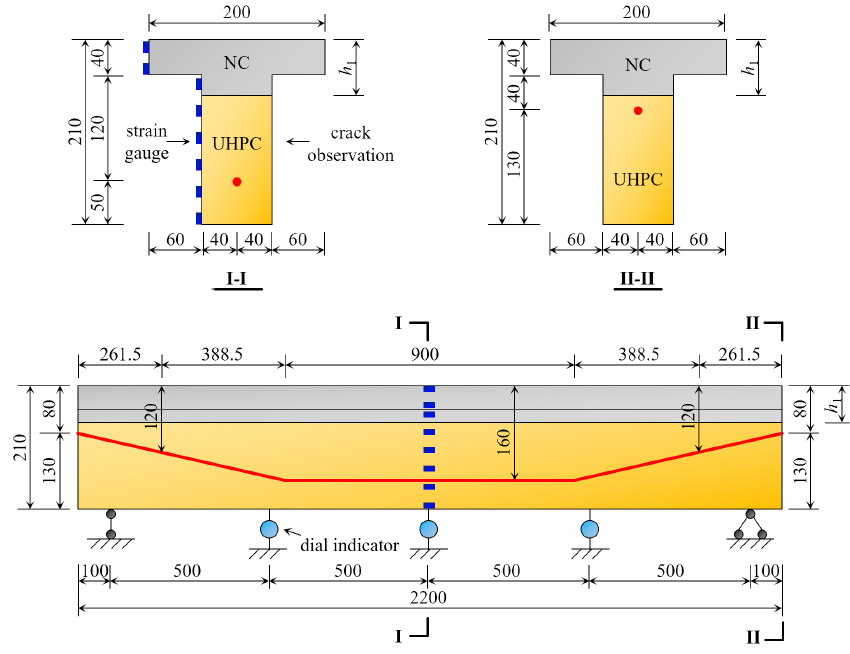
Figure 4. The size of the beam section and bundle arrangement (mm).